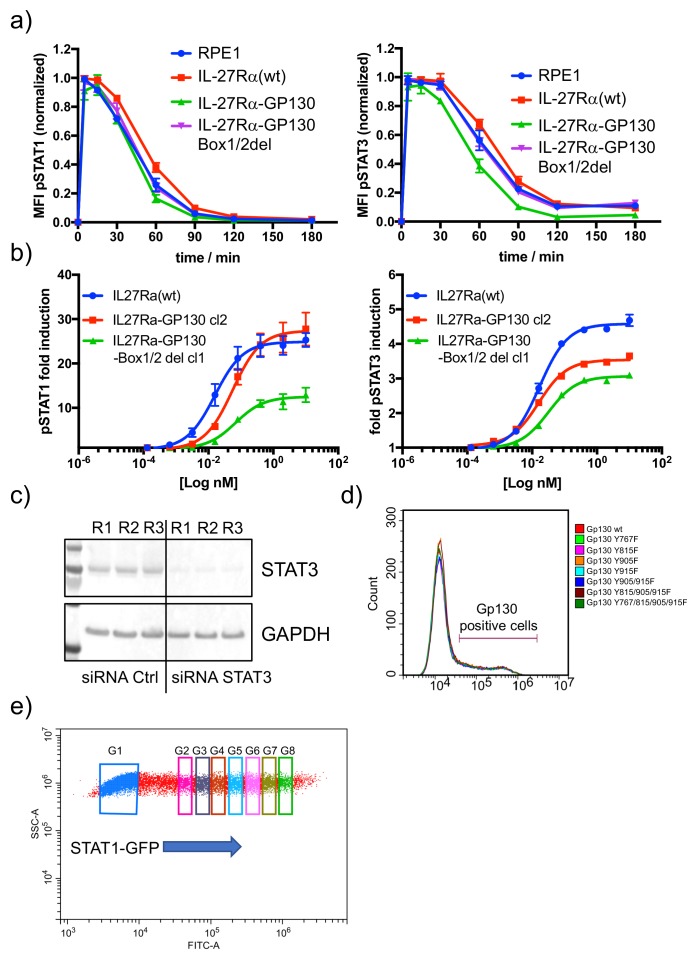
Functional characterization of RPE1 stable clones.(a) The different RPE1 stable clones were stimulated with saturating concentrations of HyIL-6 for the indicated times and the levels of STAT1 (left panel) or STAT3 (right panel) activation were measured by phospho-Flow cytometry. Data are mean + /- SEM from three independent replicates, each perform in duplicate. (b) The different RPE1 stable clones were stimulated with the indicated doses of IL-27 for 15 min and the levels of STAT1 (left panel) and STAT3 (right panel) activation were measured by Phospho-Flow cytometry. Data are mean + /- SEM from three independent replicates, each perform in duplicate. (c) HeLa cells were transfected with control siRNA or STAT3 specific siRNA and 48 hr later levels of STAT3 were measured by western blot. GAPDH was used as loading control. (d) FACS dot plot illustrating STAT1-GFP overexpression in HeLa cells. Gate (G) one to G8 represent different STAT1 expression levels.